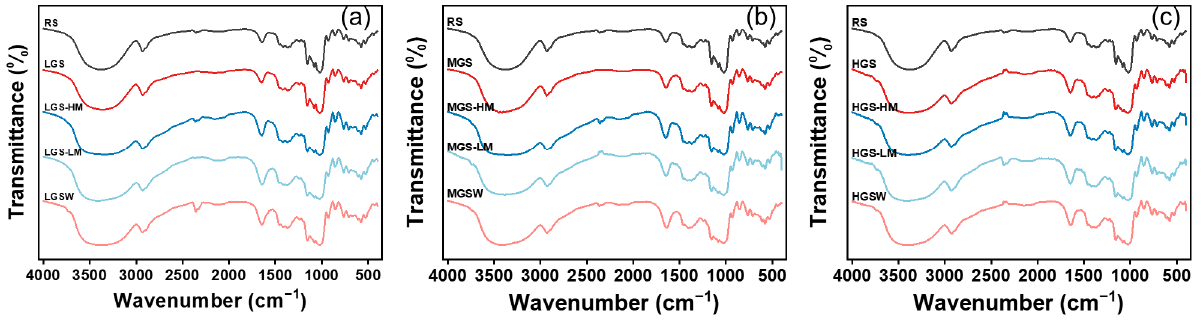
Figure 2. FTIR spectra of LGS ( a ), MGS ( b ) and HGS ( c ) reheated by different methods. Table 2. Ratios of absorbance at 1047/1022 cm − 1 and 995/1022 cm − 1 of starch samples. Type of